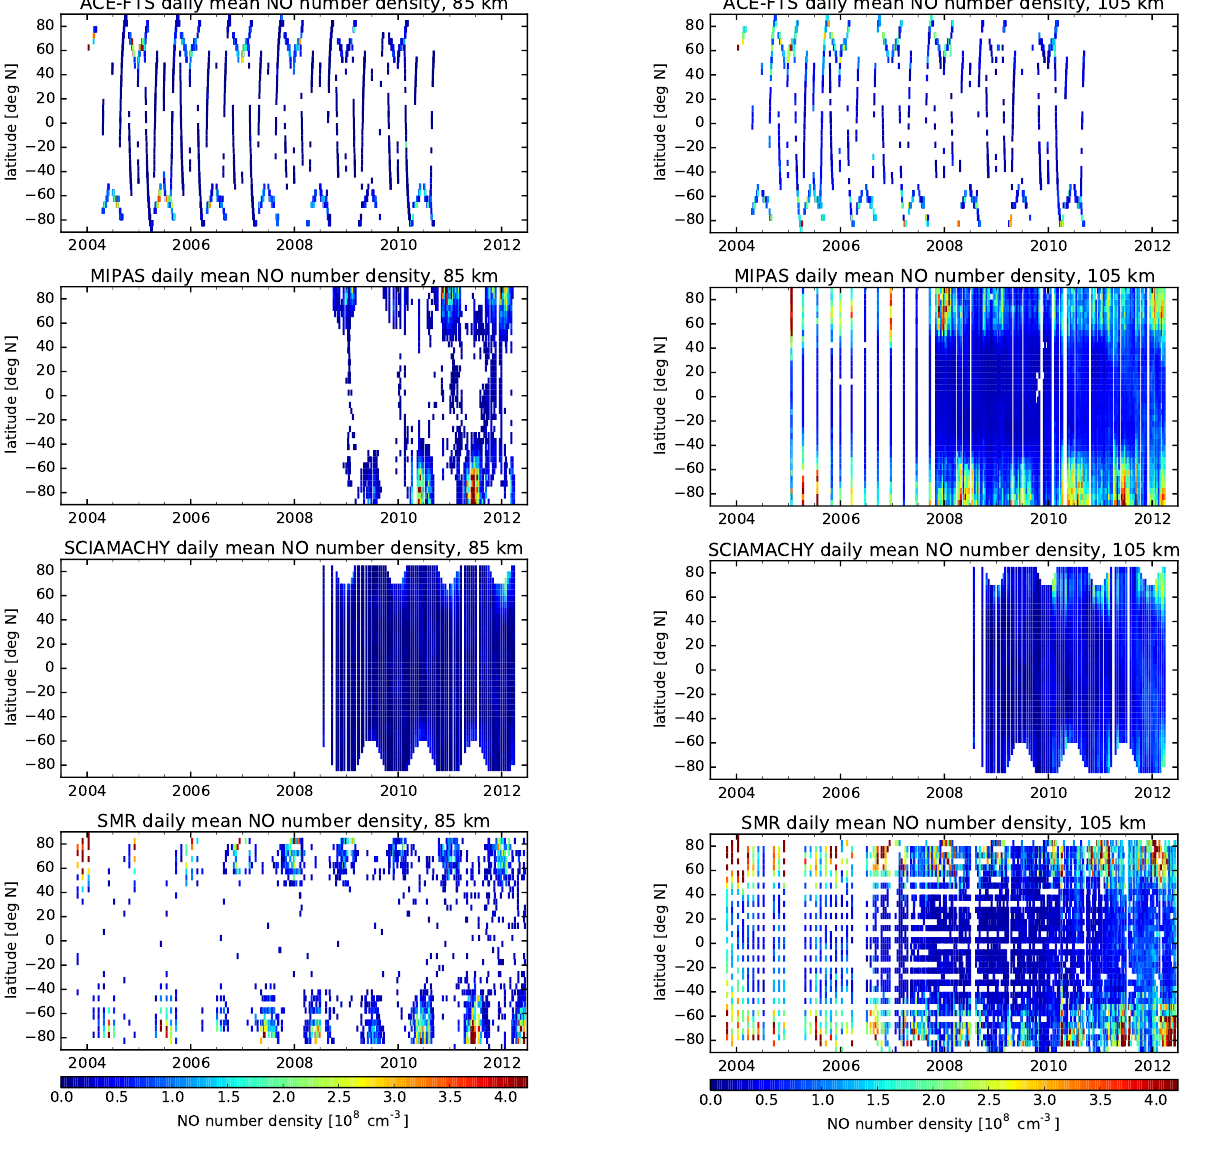
Figure 2. NO zonal mean time series at 105km from ACE-FTS, MIPAS, SCIAMACHY, and SMR (from top to